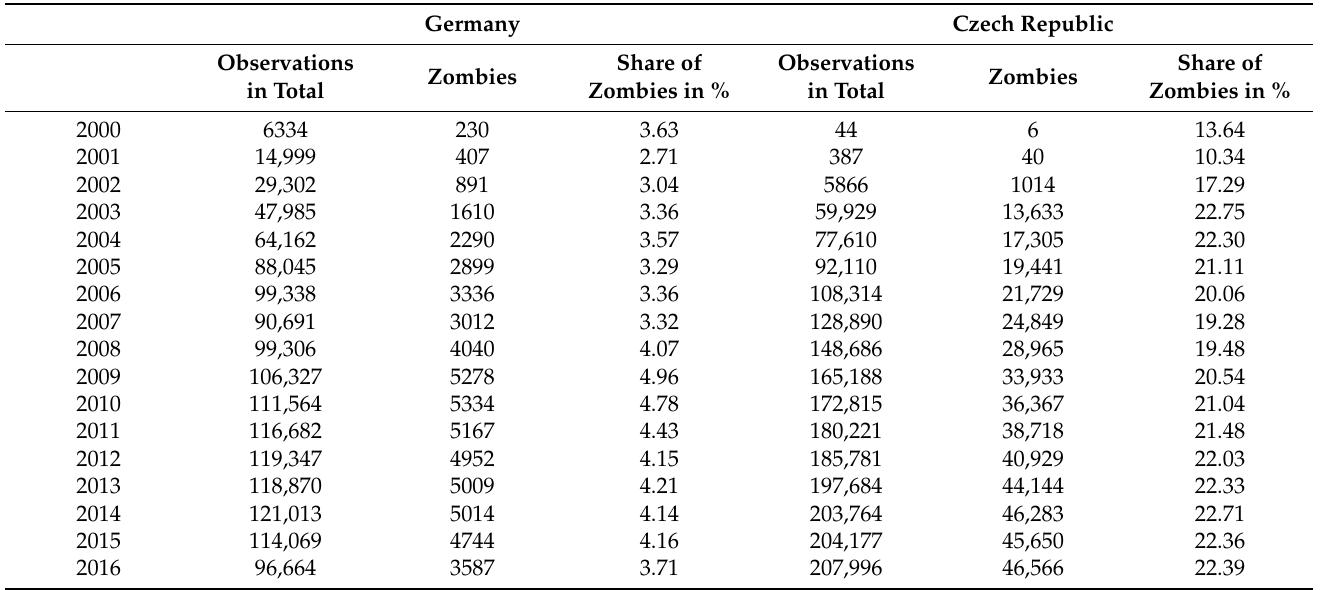
Table 1. Dataset structure concerning zombie/non-zombie classification (Source: Bisnode a.s., Creditreform AG; authors’ own elaboration).